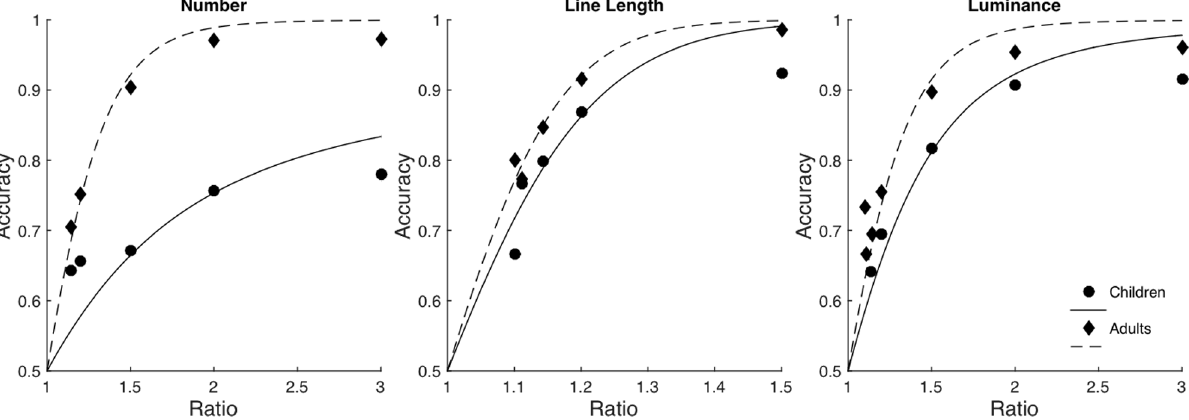
Figure 2. Mean performance in the nonsymbolic number task (A), line length task (B), and luminance task (C). Symbols indicate actual performance; lines indicate modeled best-fitting Weber